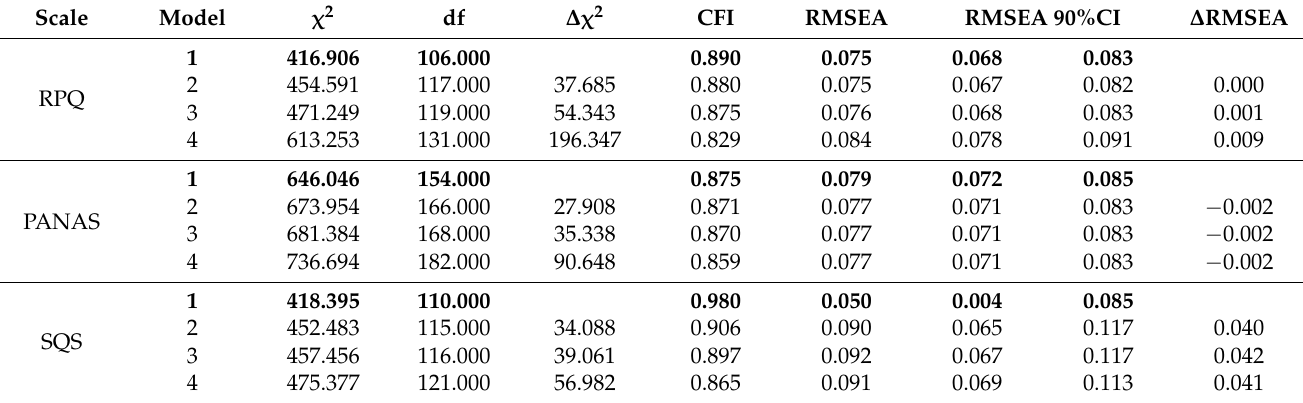
Table 3. Comparison of the measurement invariances model between Wave 1 and Wave